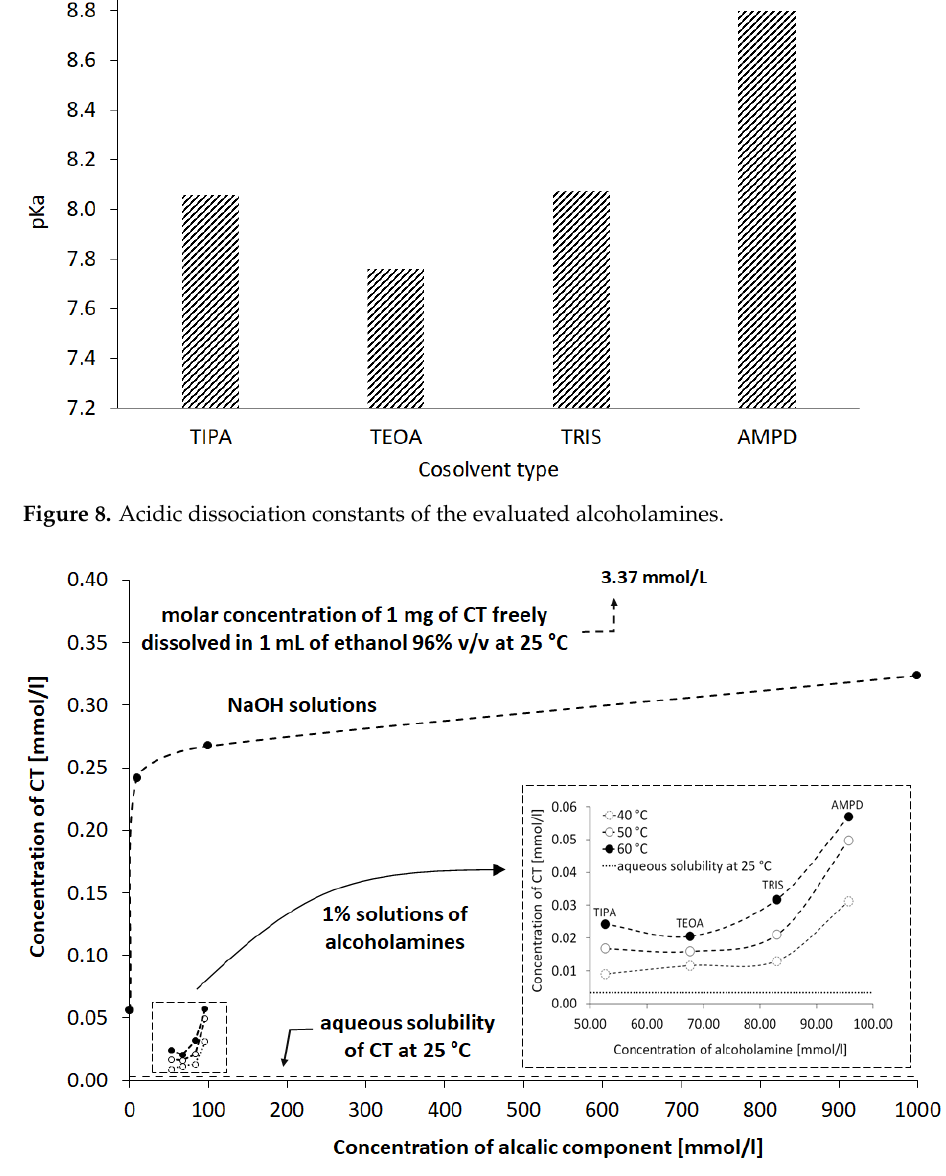
Figure 9. Influence of NaOH solutions and alcoholamine solutions on the observed concentration CT in aqueous solution compared to the CT solution in water and in ethanol. Details are provided in